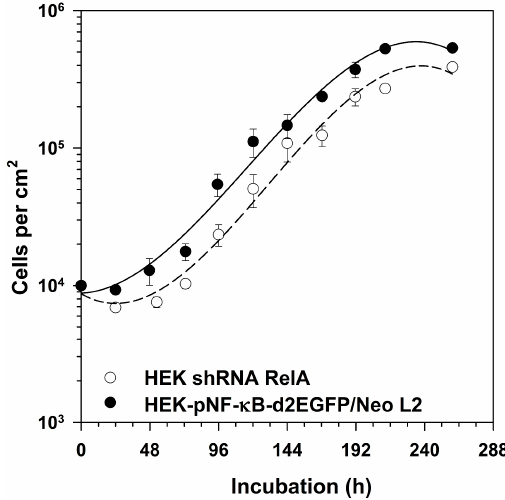
Figure 5. Growth kinetics of HEK shRNA RelA cells compared to the original cell line. 10 4 cells/cm 2 HEK-pNF- κ B-d2EGFP/Neo L2 cells and cells stably transfected with the RelA shRNA plasmid (HEK shRNA RelA) were seeded in petri dishes. On a daily base, cells were harvested by trypsination and counted in a counting chamber. The graph shows means and standard errors of three independent experiments.